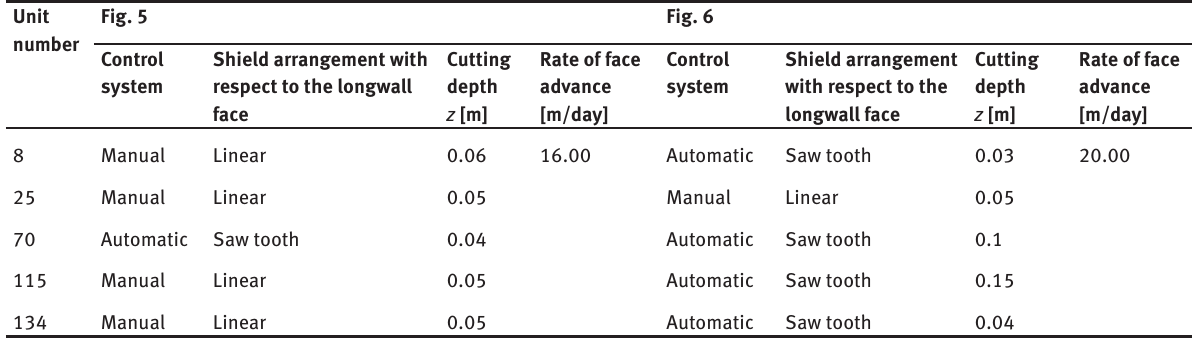
Table 2: Operating parameters of a powered roof